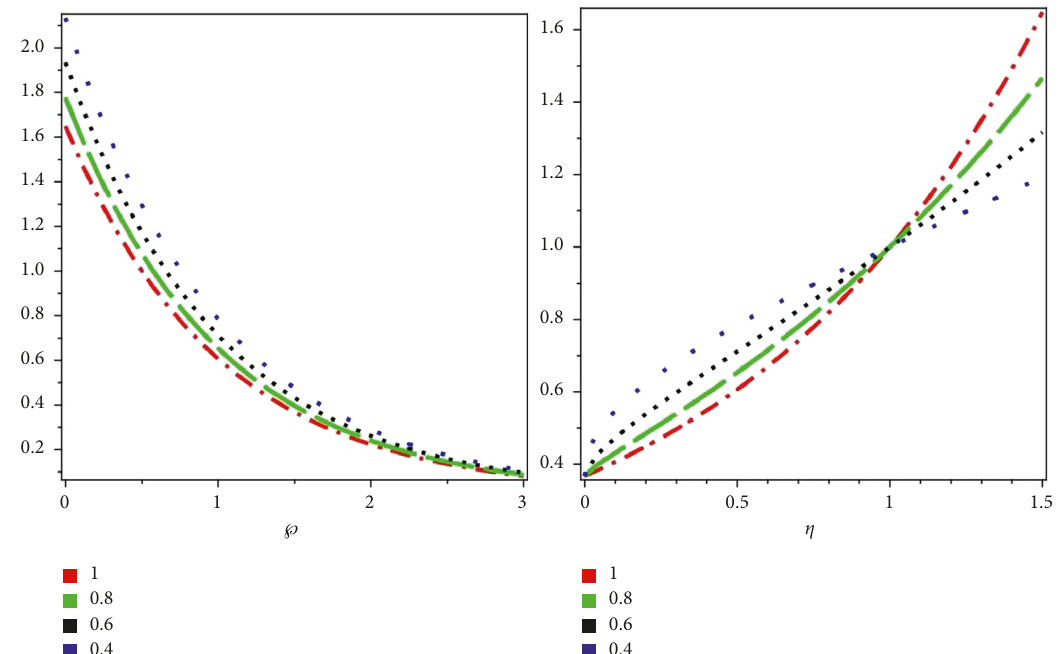
Figure 3: First figure show that the analytic result of various fractional-order of problem 3 and second graph with respect to